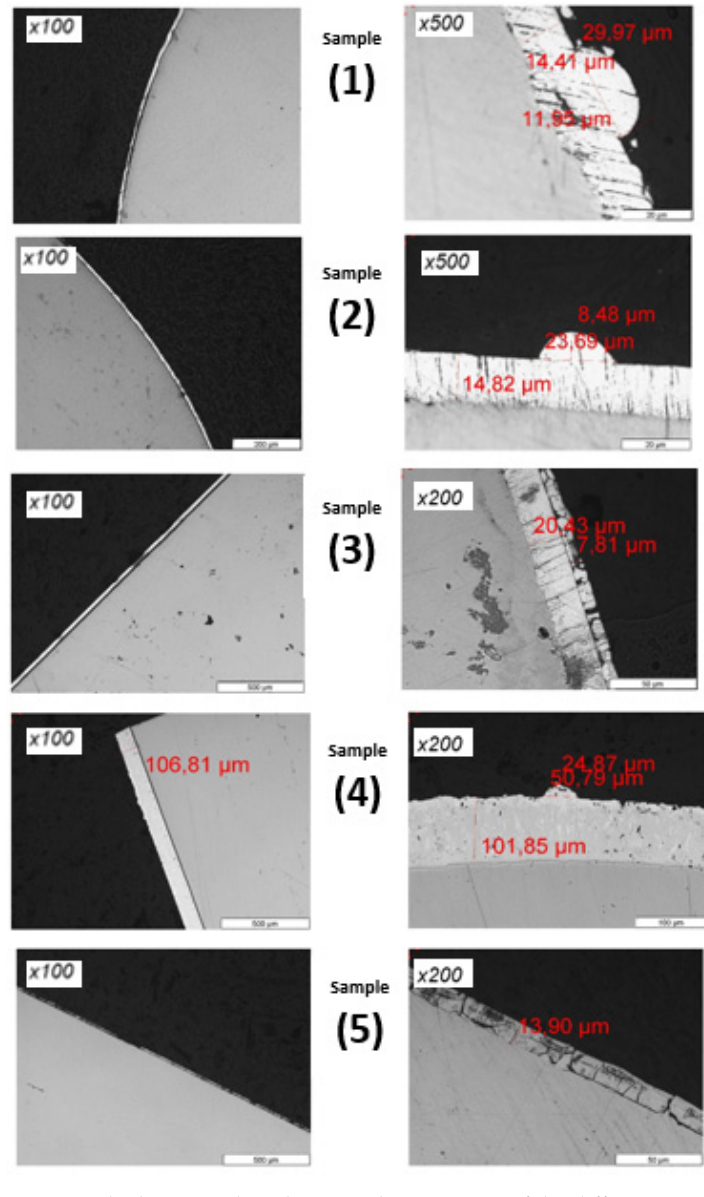
Figure 8. Thickness analysis by optical microscope of the different samples: white alkaline coating ( Sample 1 ), yellow trivalent zinc electrolyte ( Sample 2 ), acid zinc electrolyte ( Sample 3 ), hot-dip galvanizing ( Sample 4 ) and zinc-nickel ( Sample 5 ). Remark: Decimal separator in these images is “,” instead of “.”.